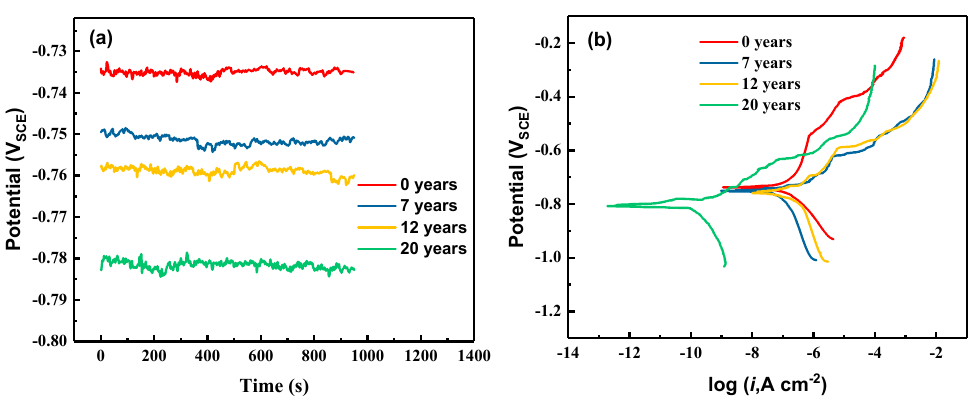
Figure 14. ( a ) Typical open circuit potential and ( b ) polarization curves for the different speci- mens. Table 4. Corresponding electrochemical corrosion parameters of the different samples obtained from Figure 14b.